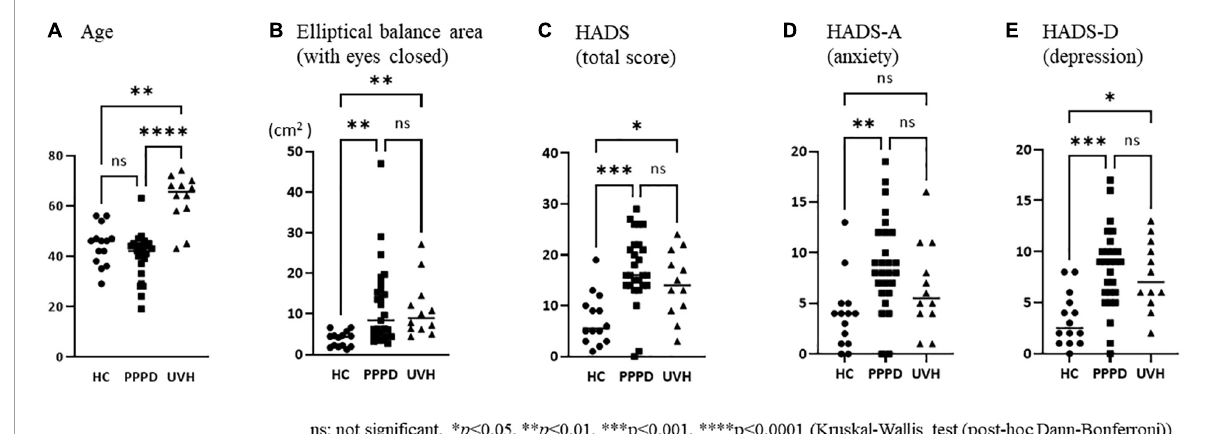
FIGURE2 Comparisons of the clinical and demographical characteristics among the three groups. (A) The mean age of patients in the unilateral vestibular hypofunction (UVH) group [median: 65.5 years, interquartile range (IQR): 11.3 years] was significantly higher than that of the participants in